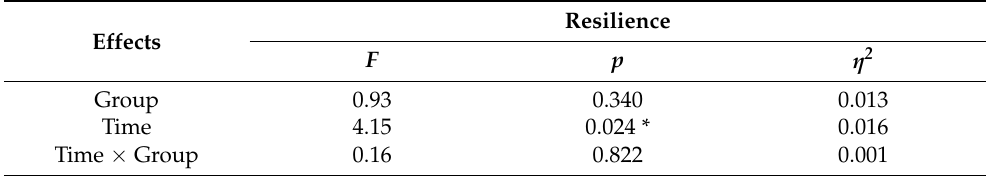
Table 7. Results of repeated-measures ANOVA for resilience.